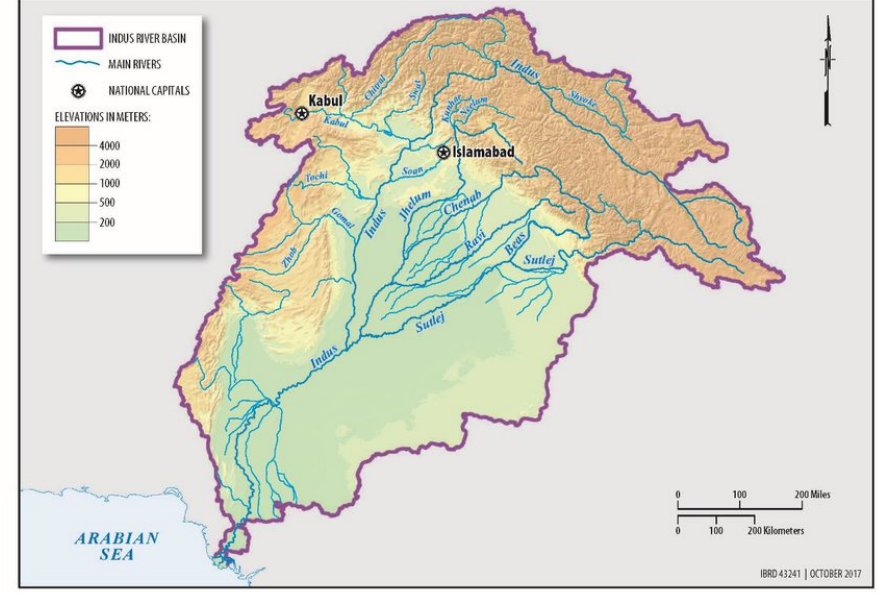
Figure 1. The Indus Basin of Pakistan